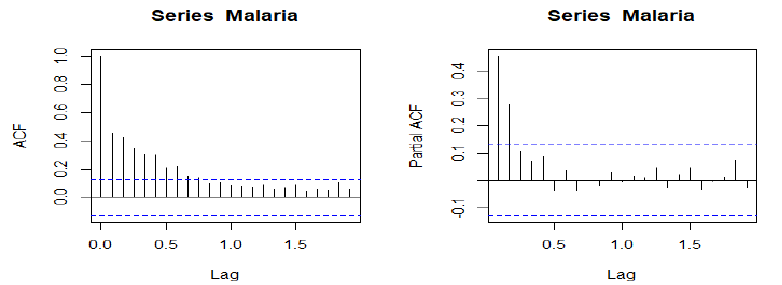
Figure 11. Total and partial autocorrelation. The blue dashed lines indicate whether the correlations are significantly different from